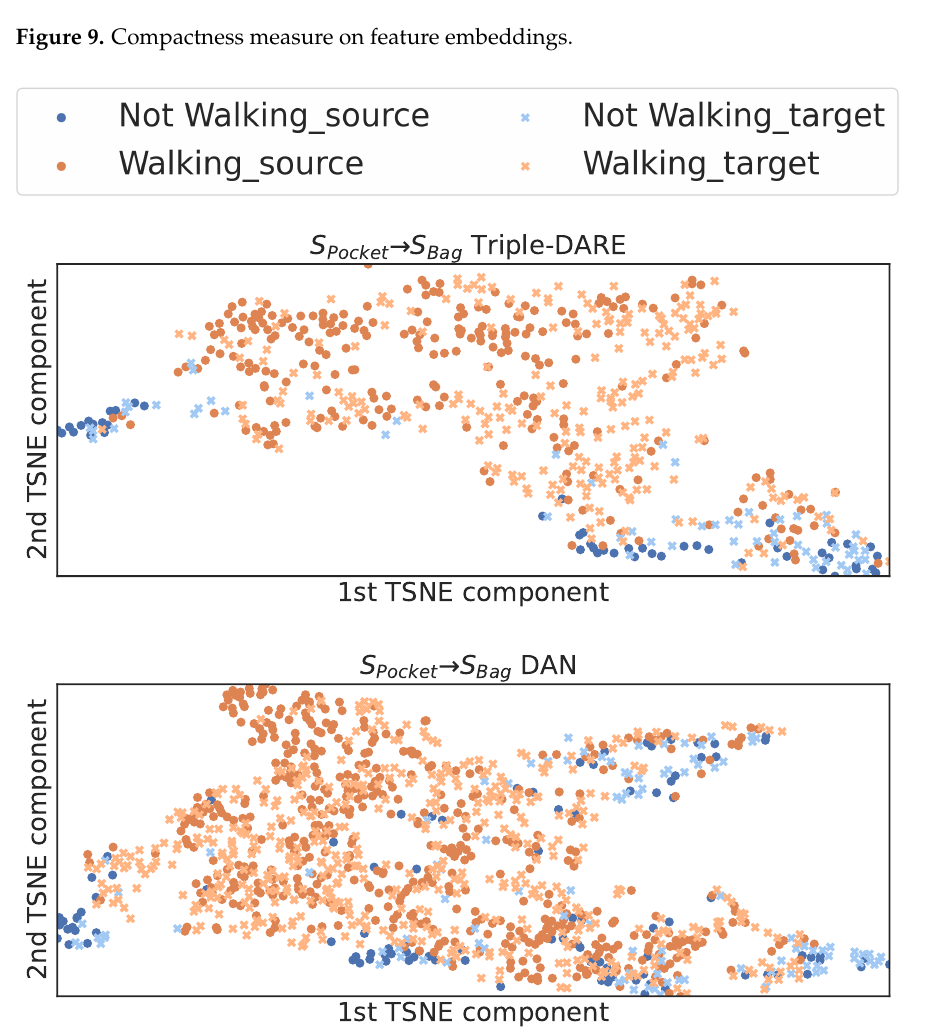
Figure 10. Visualization of the learned feature embeddings for TripleDARE ( top ) and DAN ( bottom ), using TSNE dimensional